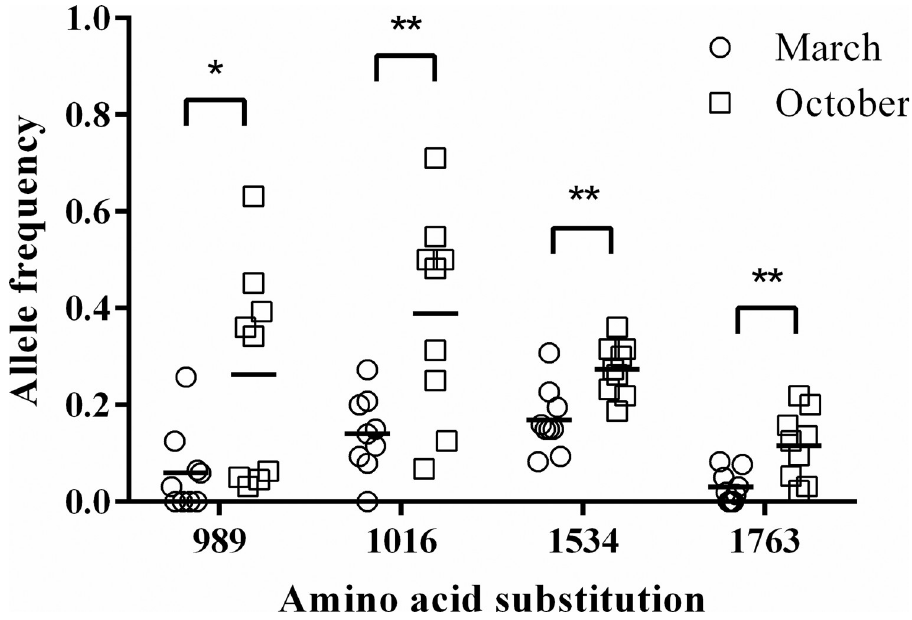
Fig 2. vgsc allele frequencies in field-collected male Ae . aegypti in March and October. All 4 mutant allele frequencies of mosquitoes collected in October were significantly ( � p < 0.05; �� p < 0.01) higher than those collected in March by unpaired t